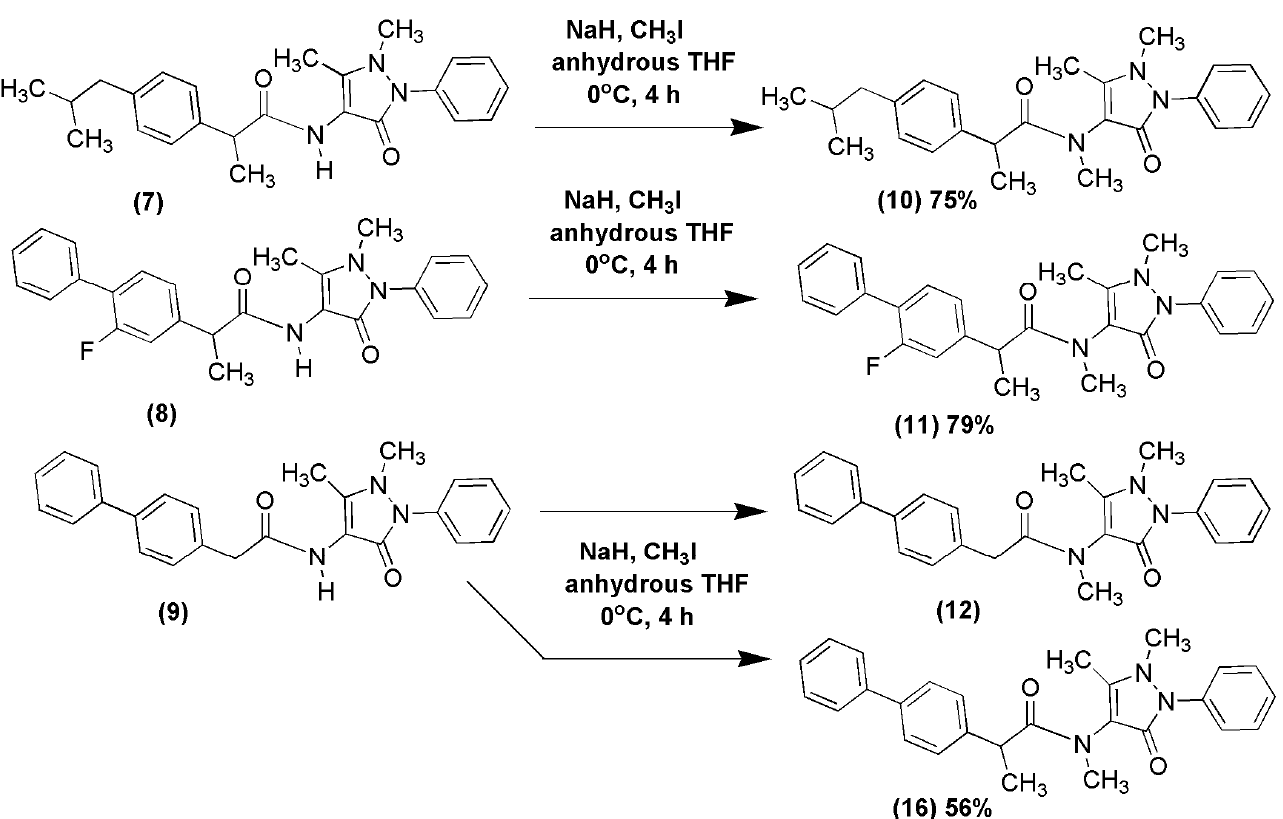
Table 1. Physicochemical and in vitro pharmacokinetic properties of pyrazolamide derivatives.